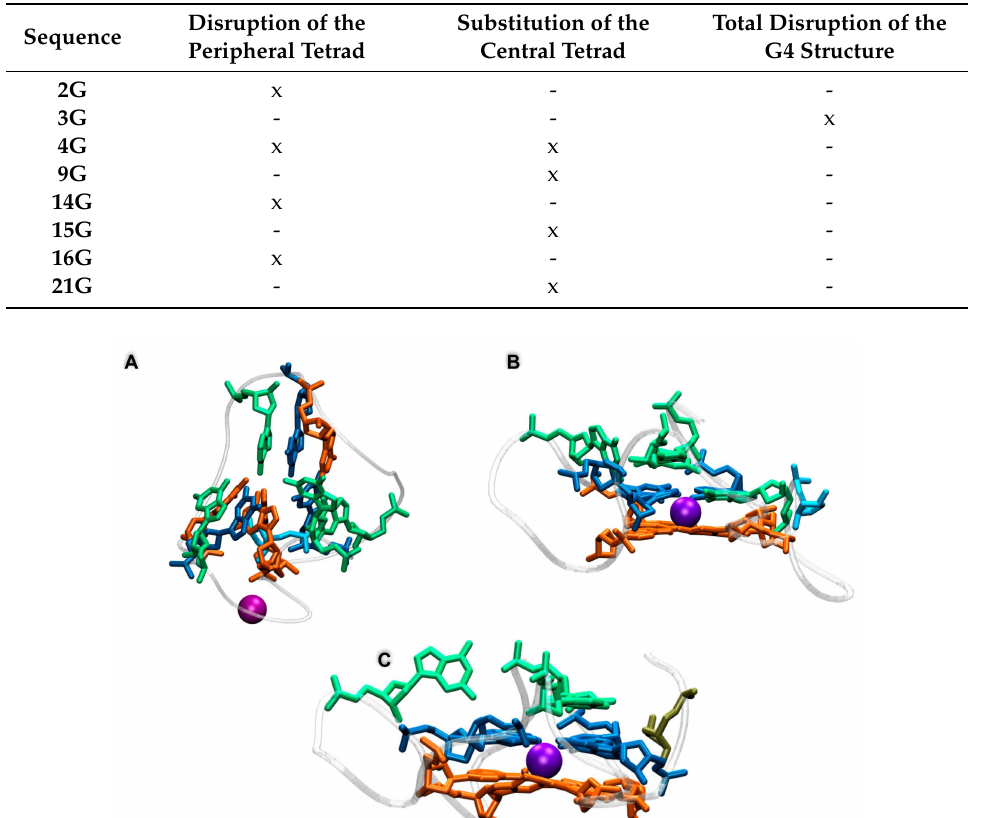
Table 1. Evolution of the G4 structure as a function of the position of the apurinic / apyrimidinic (AP) site.